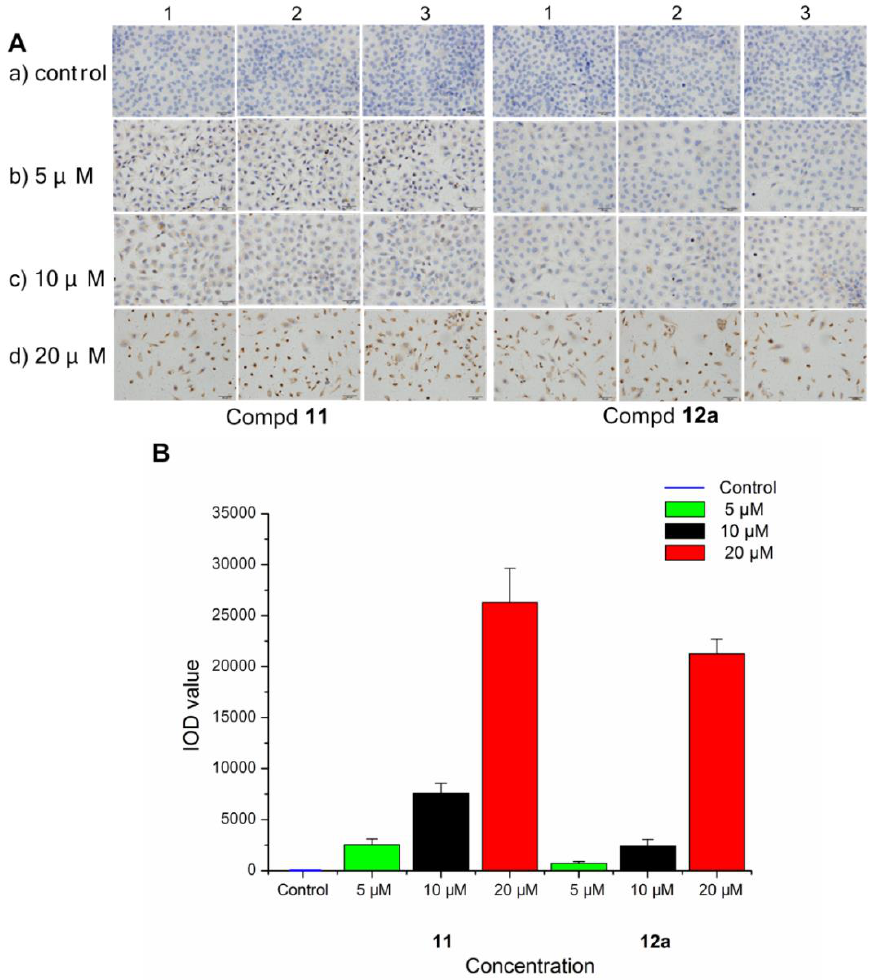
Figure 6. Immunohistochemistry of ERα in MCF-7 breast cancer cells treated with compound 11 / 12a at different concentrations (5, 10, and 20 μM), respectively, and a group without treatment as the control. ( A ) The observed phenomenon with the treatment of compound 11 and 12a in MCF-7 cells . ( B ) The IOD value detected in the treated MCF-7 cells.